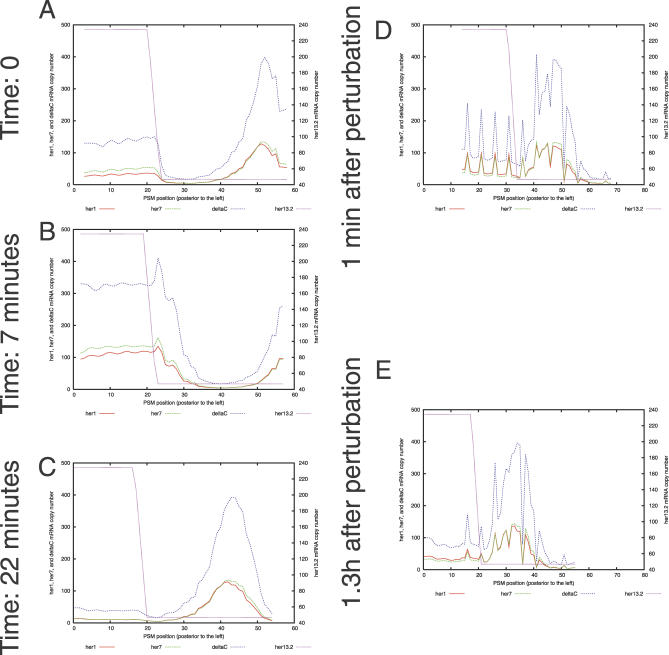
Deterministic Simulations of a Chain of Oscillators Corresponding to the Model Sketched in Figure 1 (See Table 1 for Values of Parameters)Waves of expression spread from posterior to anterior PSM (A–C), as observed experimentally. To test the effect of oscillator-coupling through DeltaC-Notch signaling, a perturbation was induced by delaying a number of oscillators in the chain by 5 min (D). After 1.3 h, the resulting perturbations in the spatial pattern were reduced (E); note that cells corresponding to indexes smaller than 13 on the x-axis should show no perturbation, because they were added to the chain after the initial perturbation.